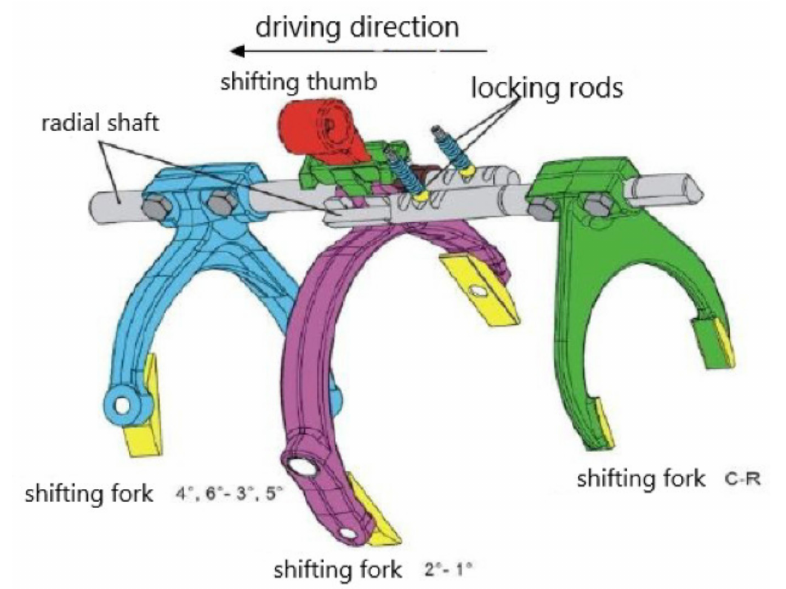
Figure 2. Gear shift fork 14TS210 including the previous version of the shifting thumb